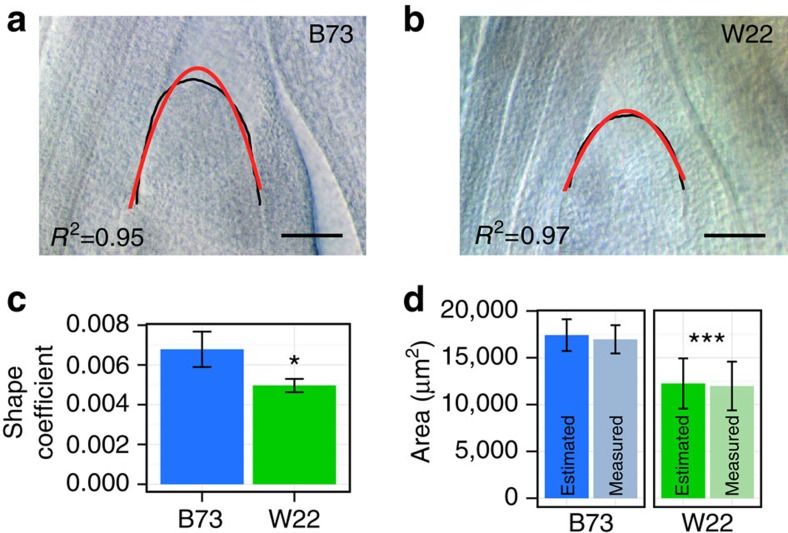
Parabolic models of the maize SAM allow rapid assessment of morphology.(a,b) Inbreds B73 and W22 have SAM morphology (black) closely approximated by a parabolic model (red). (c) Parabolic SAM model coefficients between inbreds (n=10) are significantly distinct, Student's t-test, P=0.013 (d) SAM area calculations from model-derived estimates, ‘Estimated' and direct image-processed measures, ‘Measured' are not significantly different within a genotype, but significantly different between genotypes. Two-way ANOVA—factor, genotype: P=0.000325; factor, measurement technique: P=0.750547; interaction, genotype and technique: P=0.939353. Scale bars, 100 μm. Error bars, 95% CI.